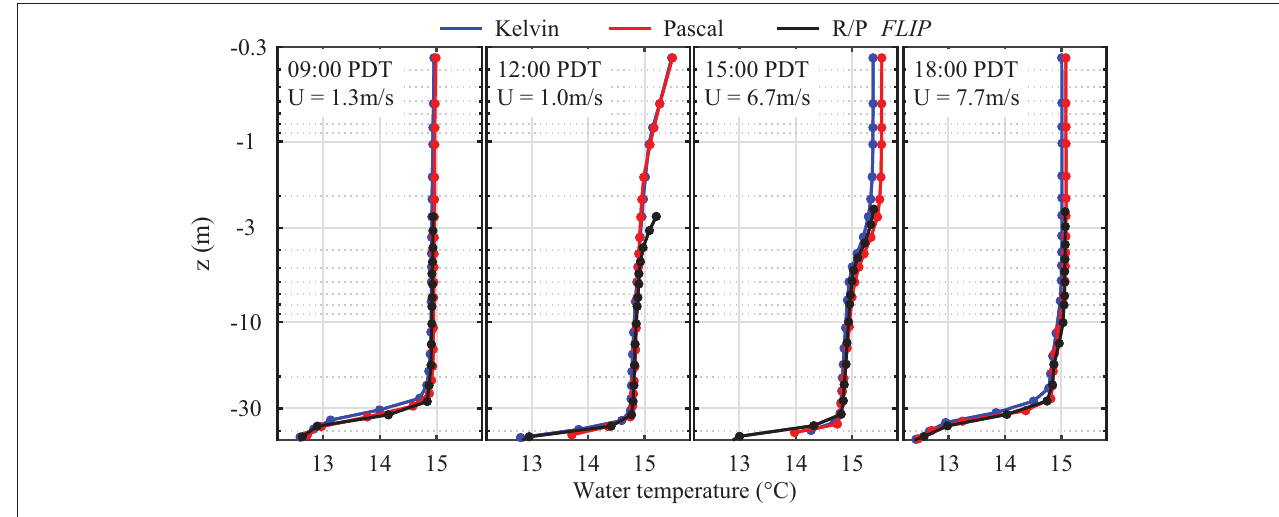
FIGURE 12 | Water temperature profiles during LCDRI2017 measured 3 h apart starting at 1600 UTC (0900 local time) 24 March 2017. The water profiles were measured from T-Chains mounted on the R/P FLIP (black) and on the SV2 Wave Gliders Kelvin (blue) and Pascal (red). In each panel, local Pacific Daylight Time (PDT) and wind speed are reported. Horizontal axis corresponds to water temperature ranging from 12.2 to 16.2 ◦ C. Data collected by the Wave Gliders close to the surface highlight the warming of the top layer (first meter below the surface) while the wind was light. Because of enhanced mixing when the wind later increases, the heat accumulated in this top layer was mixed and transported throughout the ocean mixed layer